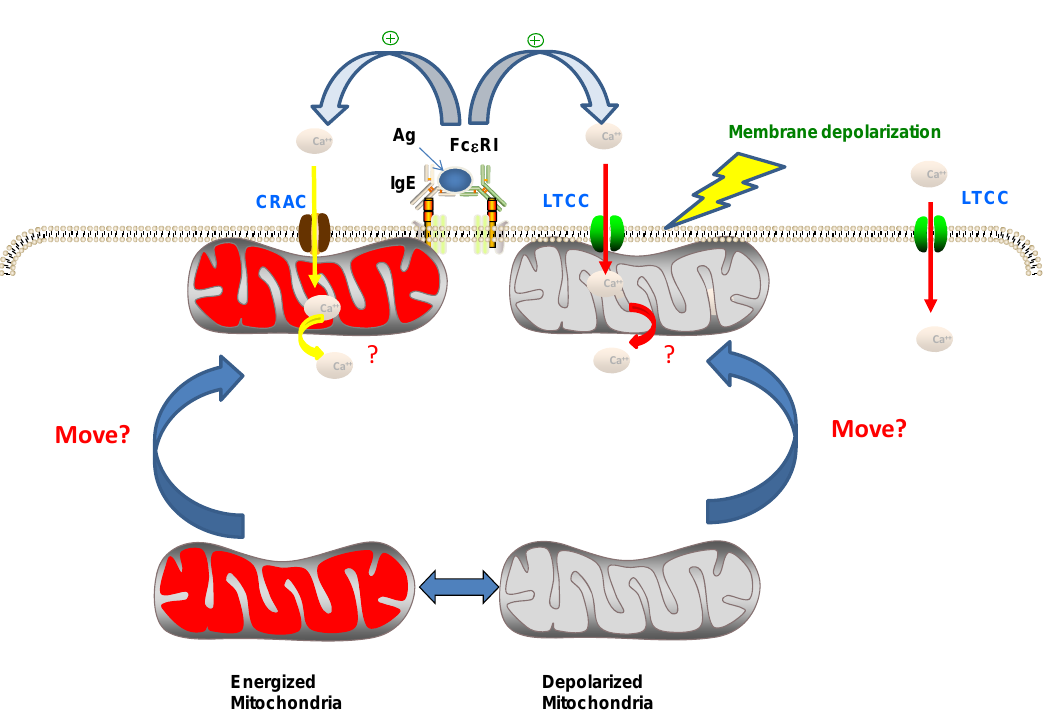
Figure 1. A model for Ca 2+ signaling in mast